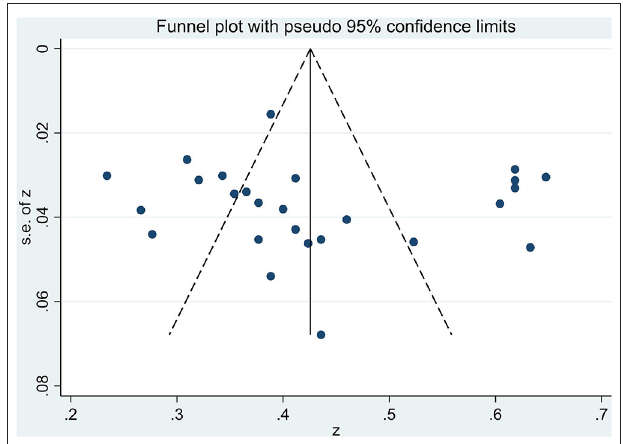
FIGURE 8 | Funnel plot of the 26 studies included in the meta-analysis.